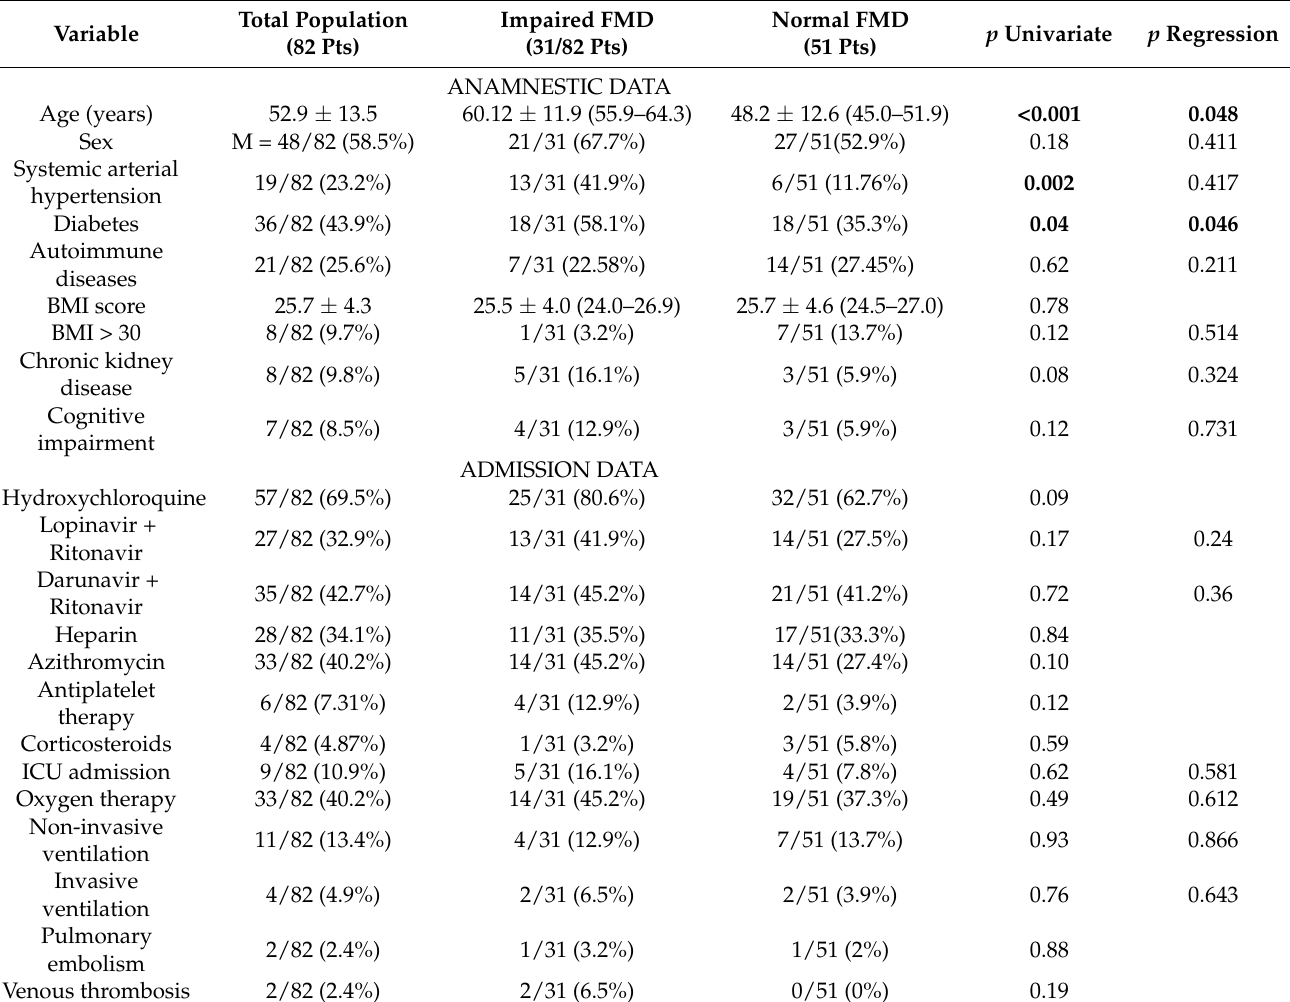
Table 1. Demographic and clinical features of the enrolled patients. Anamnestic and hospital admission variables in the total study population (82 patients), subgroup of subjects with impaired flow-mediated dilation (FMD ≤ 7%), and patients with normal values of FMD (51 patients). The last two columns on the right show the p value derived from univariate analysis and the p value derived from binary logistic regression comparing the two mentioned subgroups. The significant correlation between both demographic and clinical feature and FMD impairment was reported in